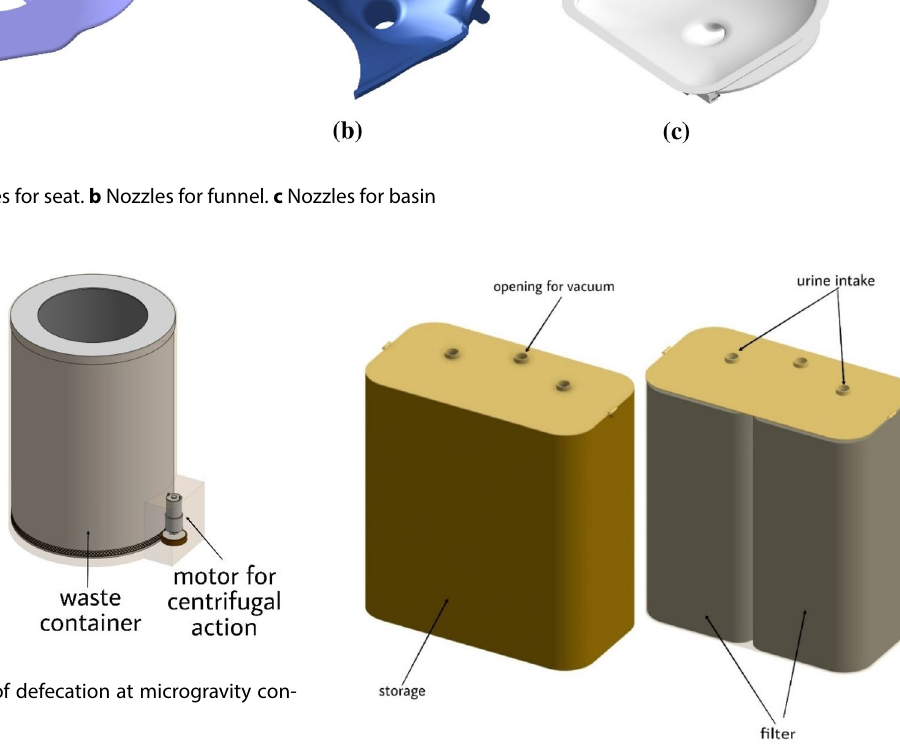
Fig. 8 Mechanism for collection of